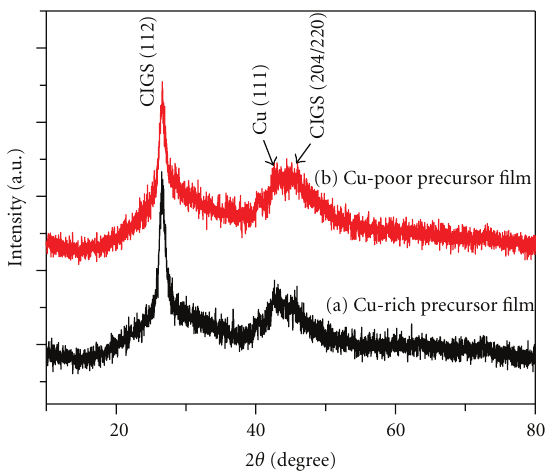
Figure 1: XRD patterns of the precursor films of two di ff erent com- positions: (a) Cu-rich precursor film, (b) Cu-poor precursor